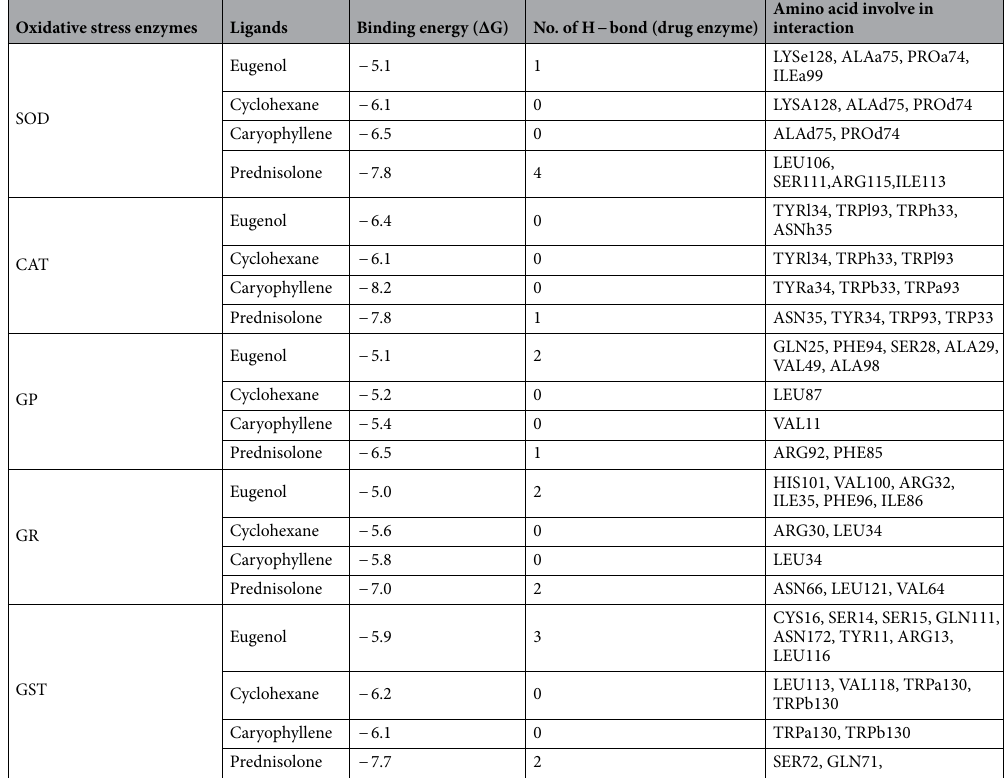
Table 1. Molecular docking analysis of several phytocompounds against oxidative stress